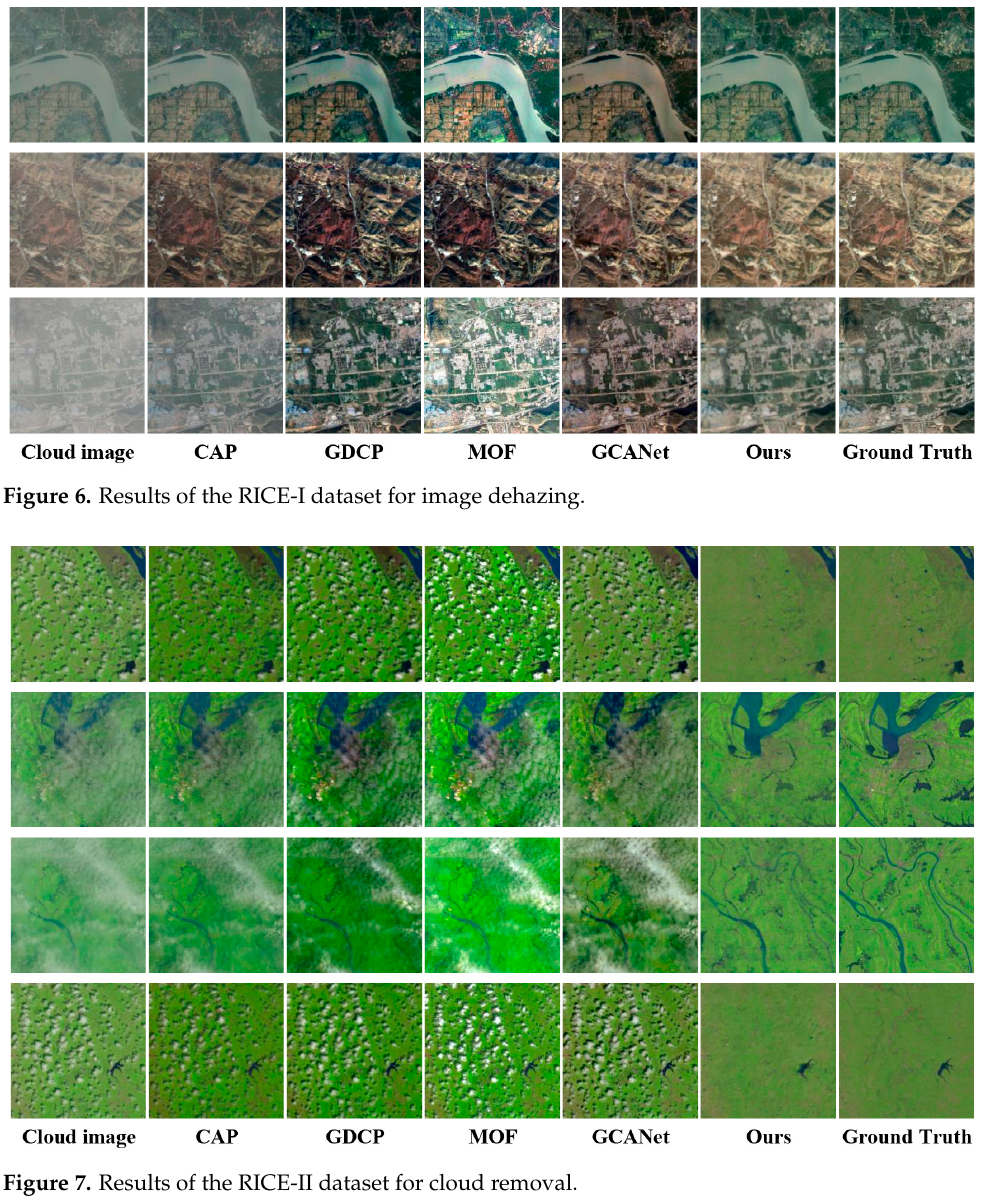
Figure 6. Results of the RICE-I dataset for image dehazing.